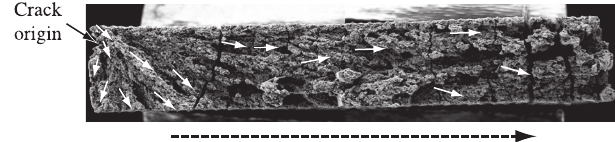
Figure 6. Map of overall crack propagation direction (White arrows indicate local crack propagation direction and the dotted arrow indicate overall crack propagation direction).